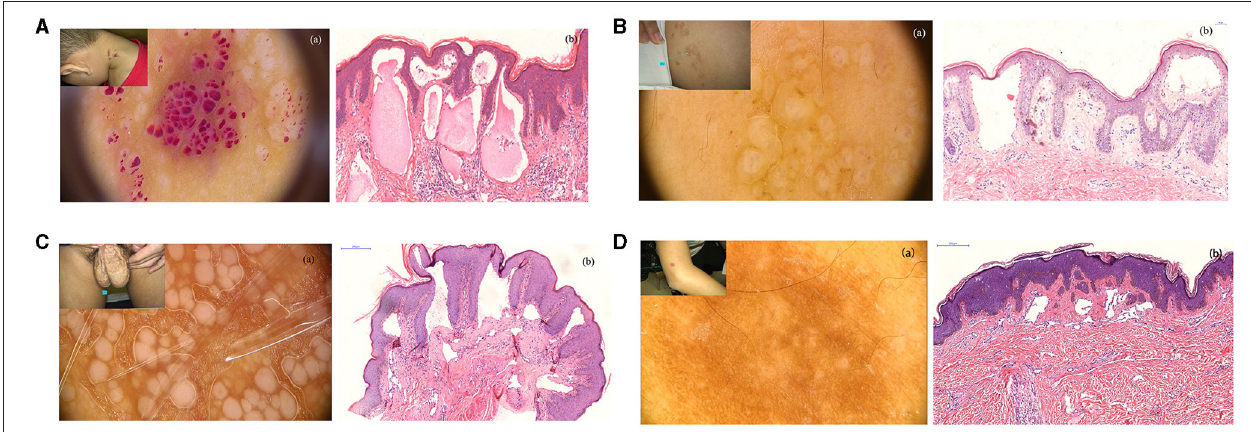
FIGURE 1 | (A) Clinical manifestations of patients with cutaneous lymphangioma circumscriptum (CLC), a cluster of vesicular dark reddish/complexion on the neck for 3 years; (a) reddish, white-yellowish lacuna of different sizes, some filled with blood as hypopyon-like or crescent shapes (non-polarized, 20 × ); (b) dilated lymphatic vessels with various sizes, containing lymph, erythrocytes, and inflammatory cells. (H&E stain; original magnification, 200 × ) (300 dpi × 300 dpi). (B) Clinical manifestations of patients with CLC, lacunae on the back of the left shoulder for 2 years. The patient had a history of CLC and treatment with surgery. (a) Dermatoscopic features of patients with CLC: blister resembling frog spawn or translucent vesicles (non-polarized, 20 × ). (b) A representative histological analysis of patients with CLC shows the lumen of different sizes and lymphangiectasis. (H&E stain; original magnification, 200 × ) (300 dpi × 300 dpi). (C) Clinical manifestations of patients with CLC, papules on the scrotum for several years, liquid intermittent efflux. (a) White unstructured areas of varying sizes, independent of each other (non-polarized, 40 × ). (b) A representative histological analysis of patients with CLC shown in dilated lymphatic vessels and immunohistochemical staining, showing positive D2-40 staining (H&E stain; original magnification, 100 × ) (300 dpi × 300 dpi). (D) Clinical manifestations of patients with CLC (A), brown patch enlarging gradually on the right arm. (a) White unstructured areas in the center, brown reticular pigmentation in the periphery (non-polarized, 70 × ). (b) A representative histological analysis of patients with CLC shown in lymphangiectasis, accompanied with fibroplasia (H&E stain; original magnification, 100 × ) (300 dpi × 300 dpi).